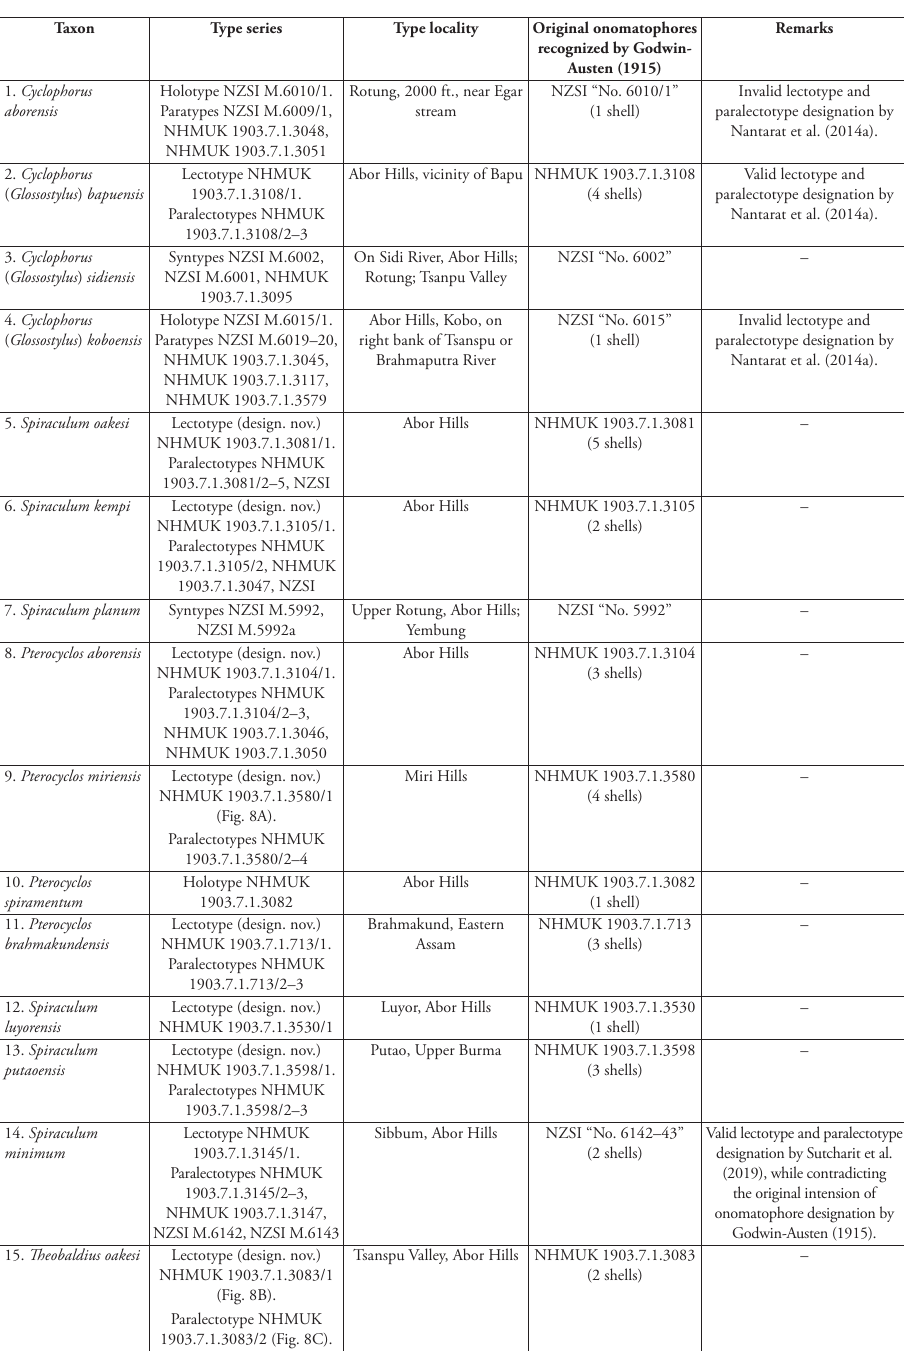
Table 1. Current status of type series, other non-type materials, type locality, and original onomato- phores of cyclophorid taxa in Godwin-Austen (1915). The number of shells in some specimen lots are unknown and not